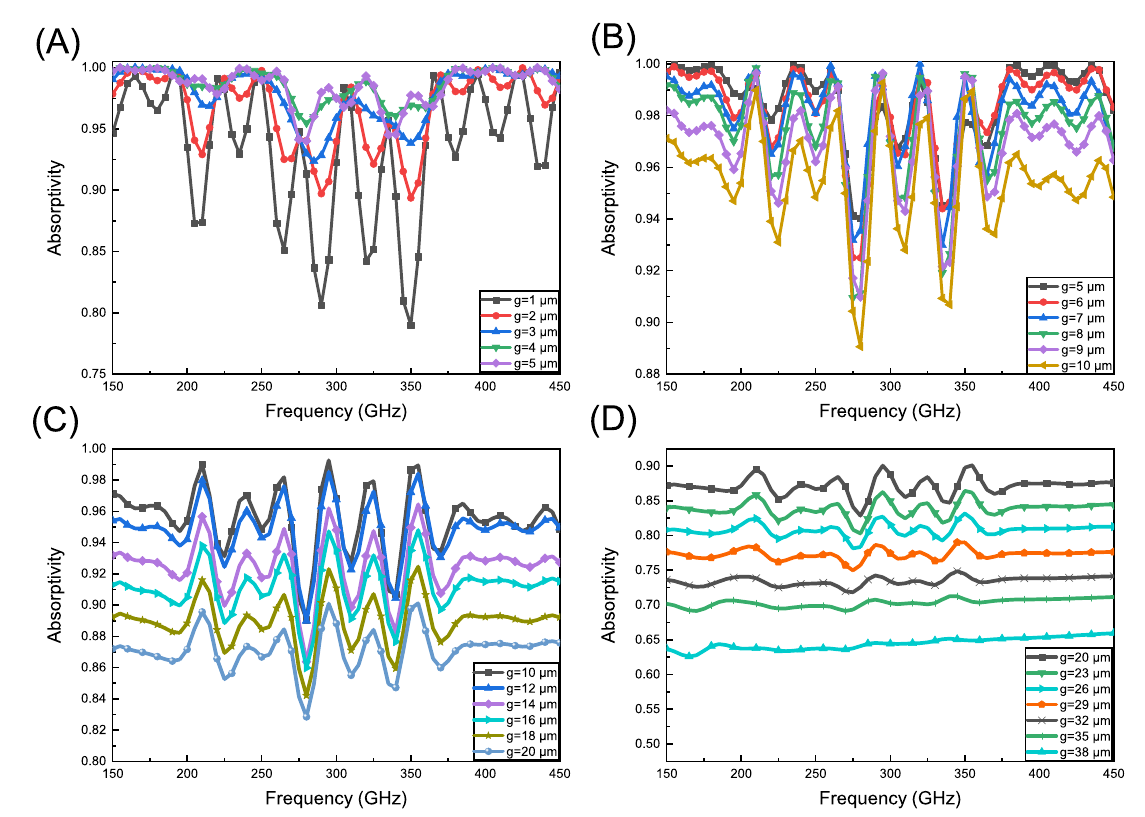
Figure 4. Absorptivity versus frequency with different g: ( A ) g = 1–5 µ m, ( B ) g = 5–10 µ m, ( C ) g = 10–20 µ m, and ( D ) g = 20–38 µ